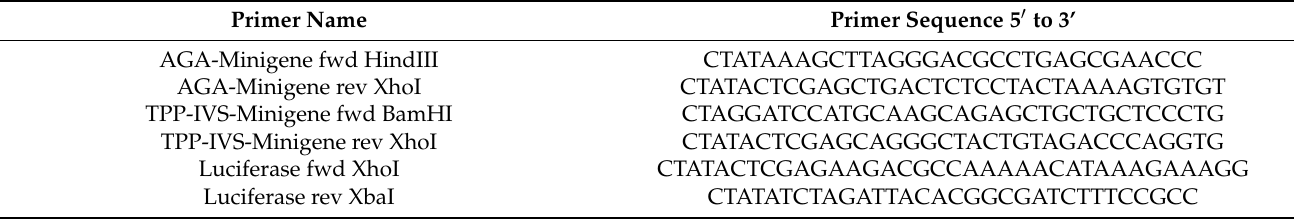
Table 1. Primer sequences for cloning of the AGA and TPP1 minigene constructs. All sequences are shown in 5 (cid:48) to 3 (cid:48)